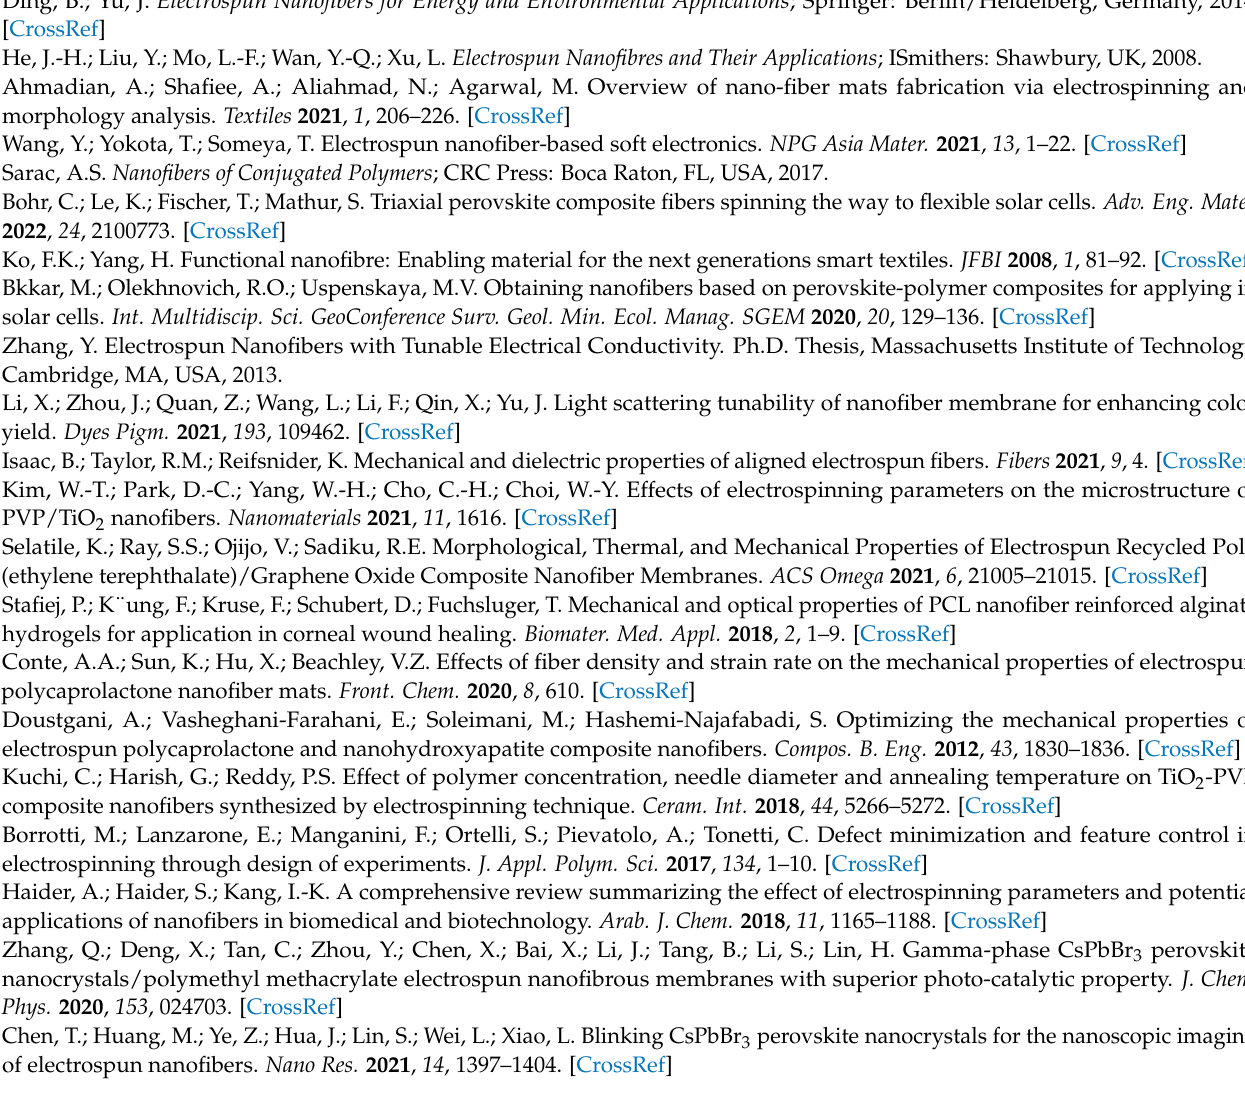
respectively. Figure S4: Tauc plots of samples at a diverse thickness. Figure S5: Tauc plots of a spin-coated layer and nanofibers for the same amount of material on the